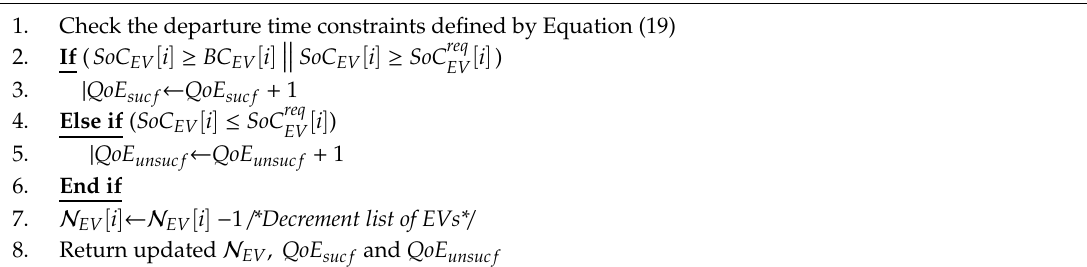
, BC EV , QoE sucf , QoE unsucf , i EV